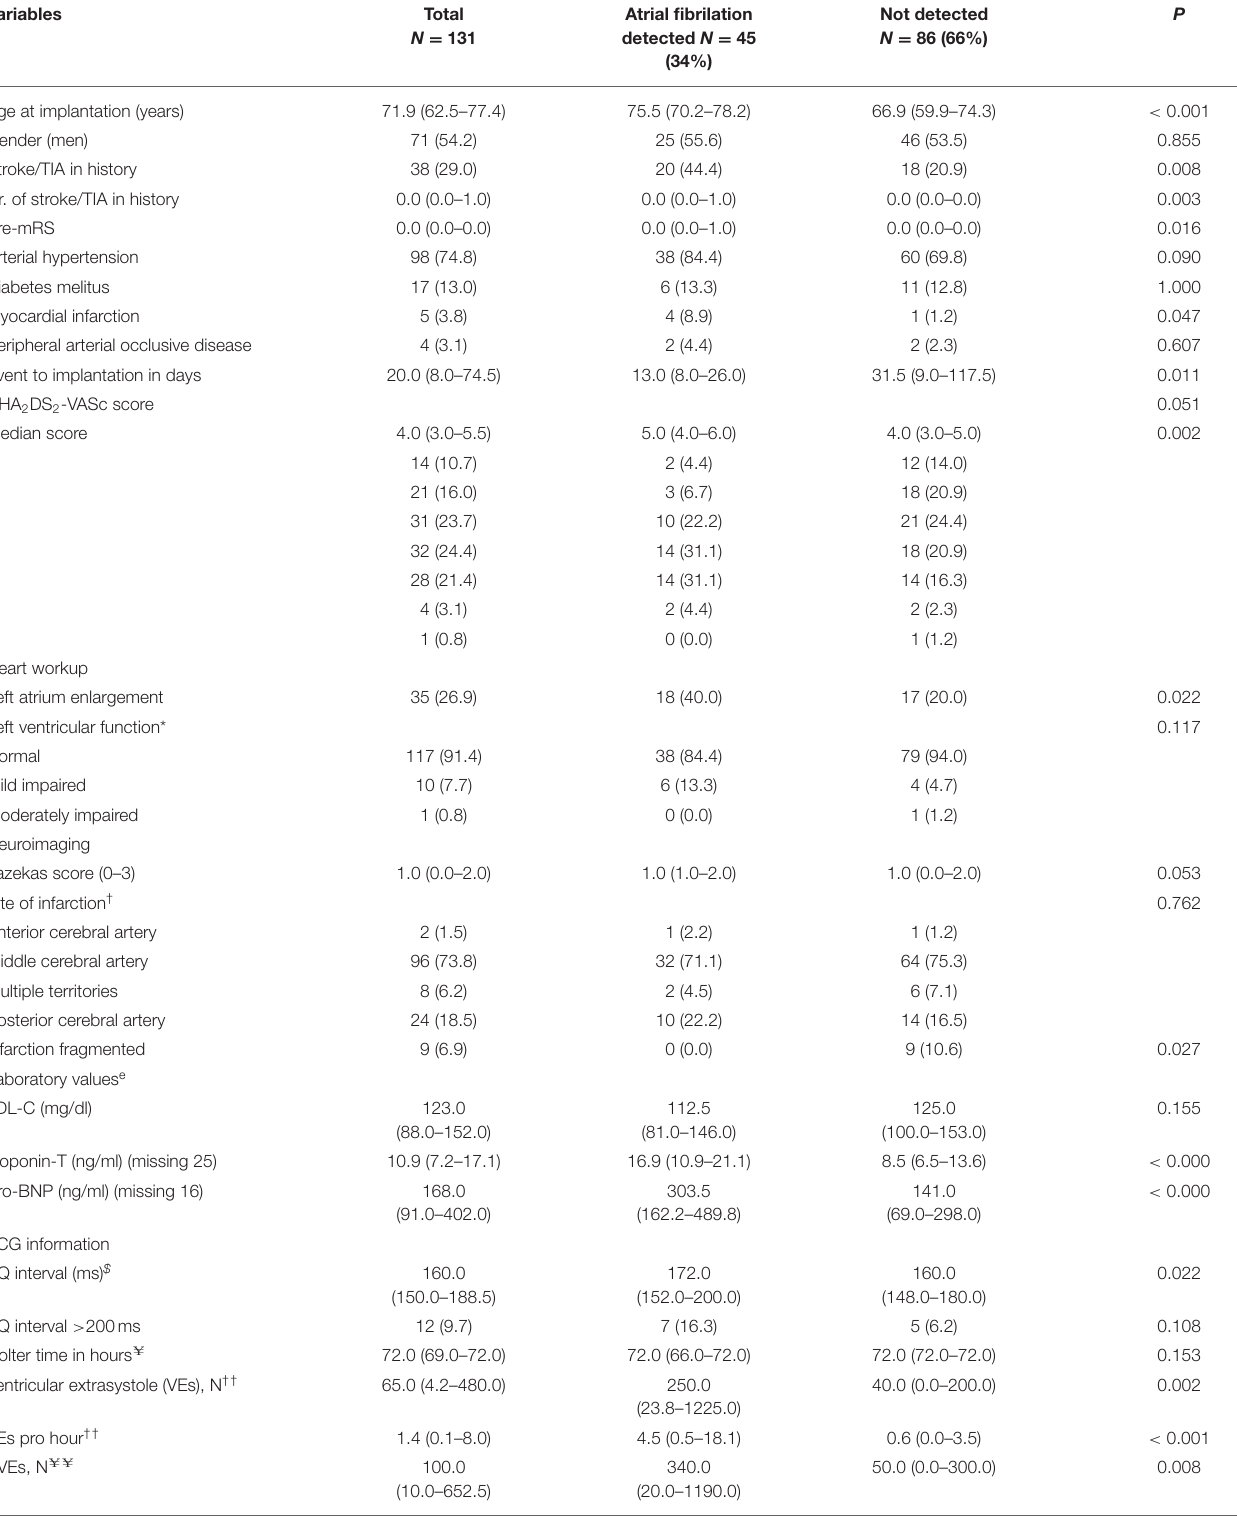
TABLE 1 | Demographic, clinical, heart- and neuroimaging, laboratory, and electrocardiographic data of 131 patients with implantable loop recorder due to embolic stroke of undetermined source in Christian–Doppler–Klinik, Salzburg in the time period 2016–2020.